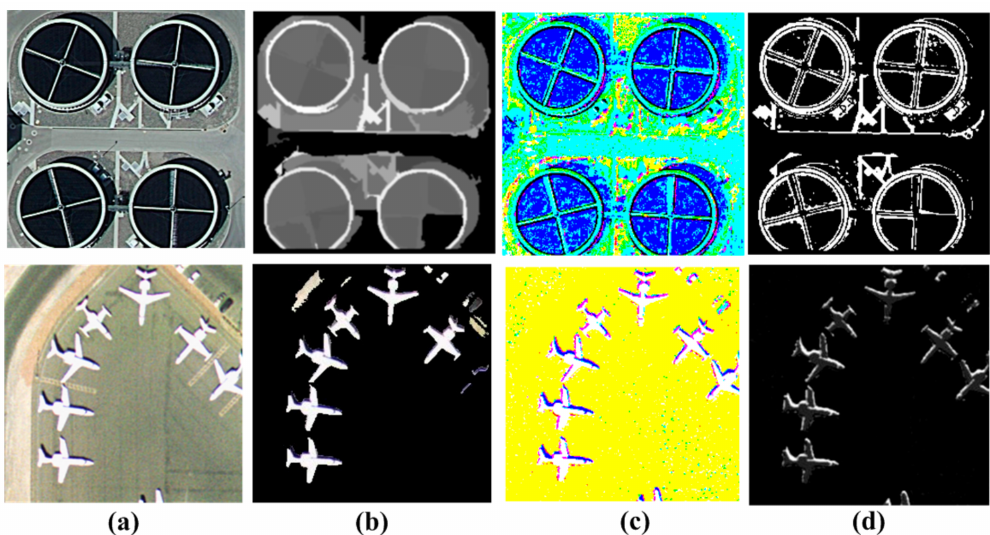
Figure 3. Example of the CBGCSRD method. ( a ) Original image; ( b ) saliency map with existing regional contrast based method; ( c ) color-boosted image; and ( d ) the proposed color-boosted saliency map.